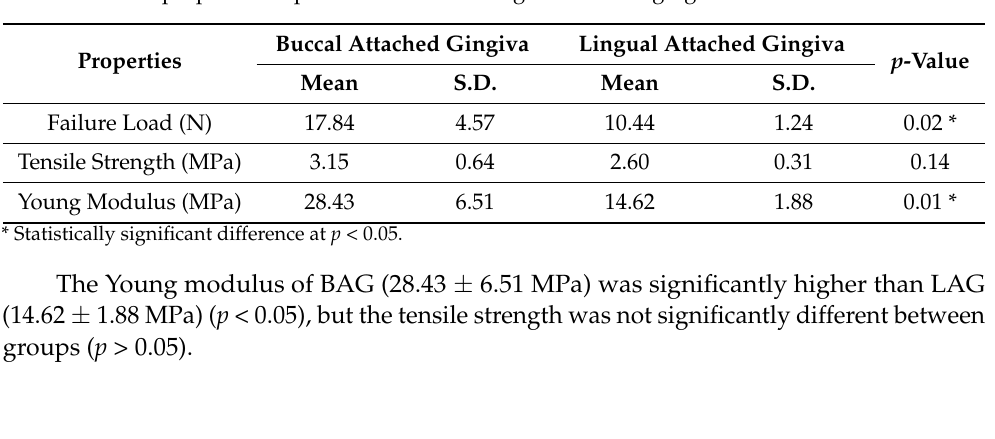
Table 2. Tensile properties of porcine buccal and lingual attached